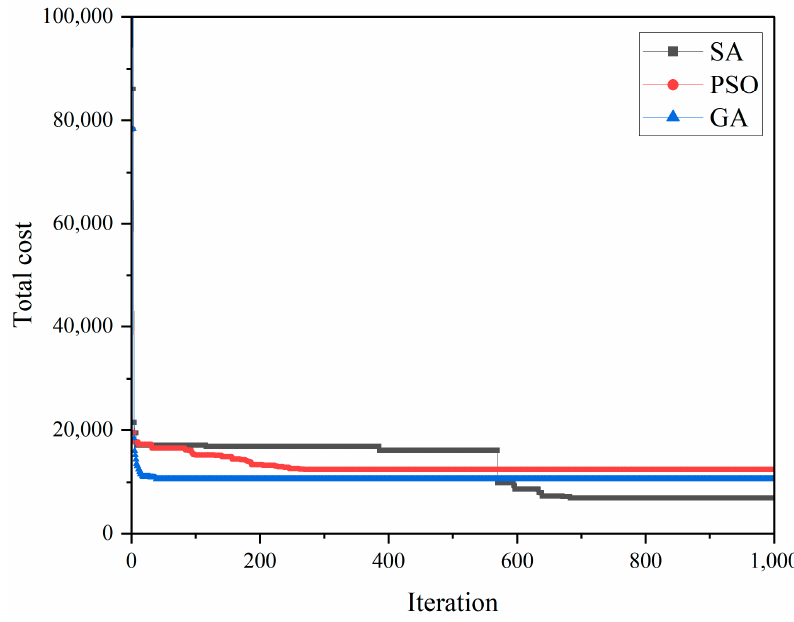
Figure 3. Convergence of the SA, PSO, and GA algorithms.